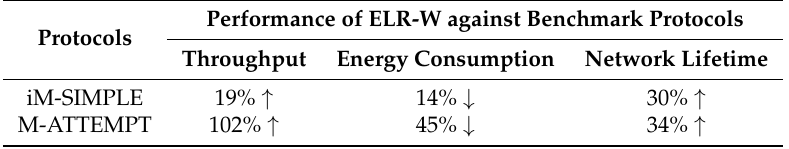
Table 4. Performance of ELR-W against competitive protocols with increase ↑ or decrease ↓